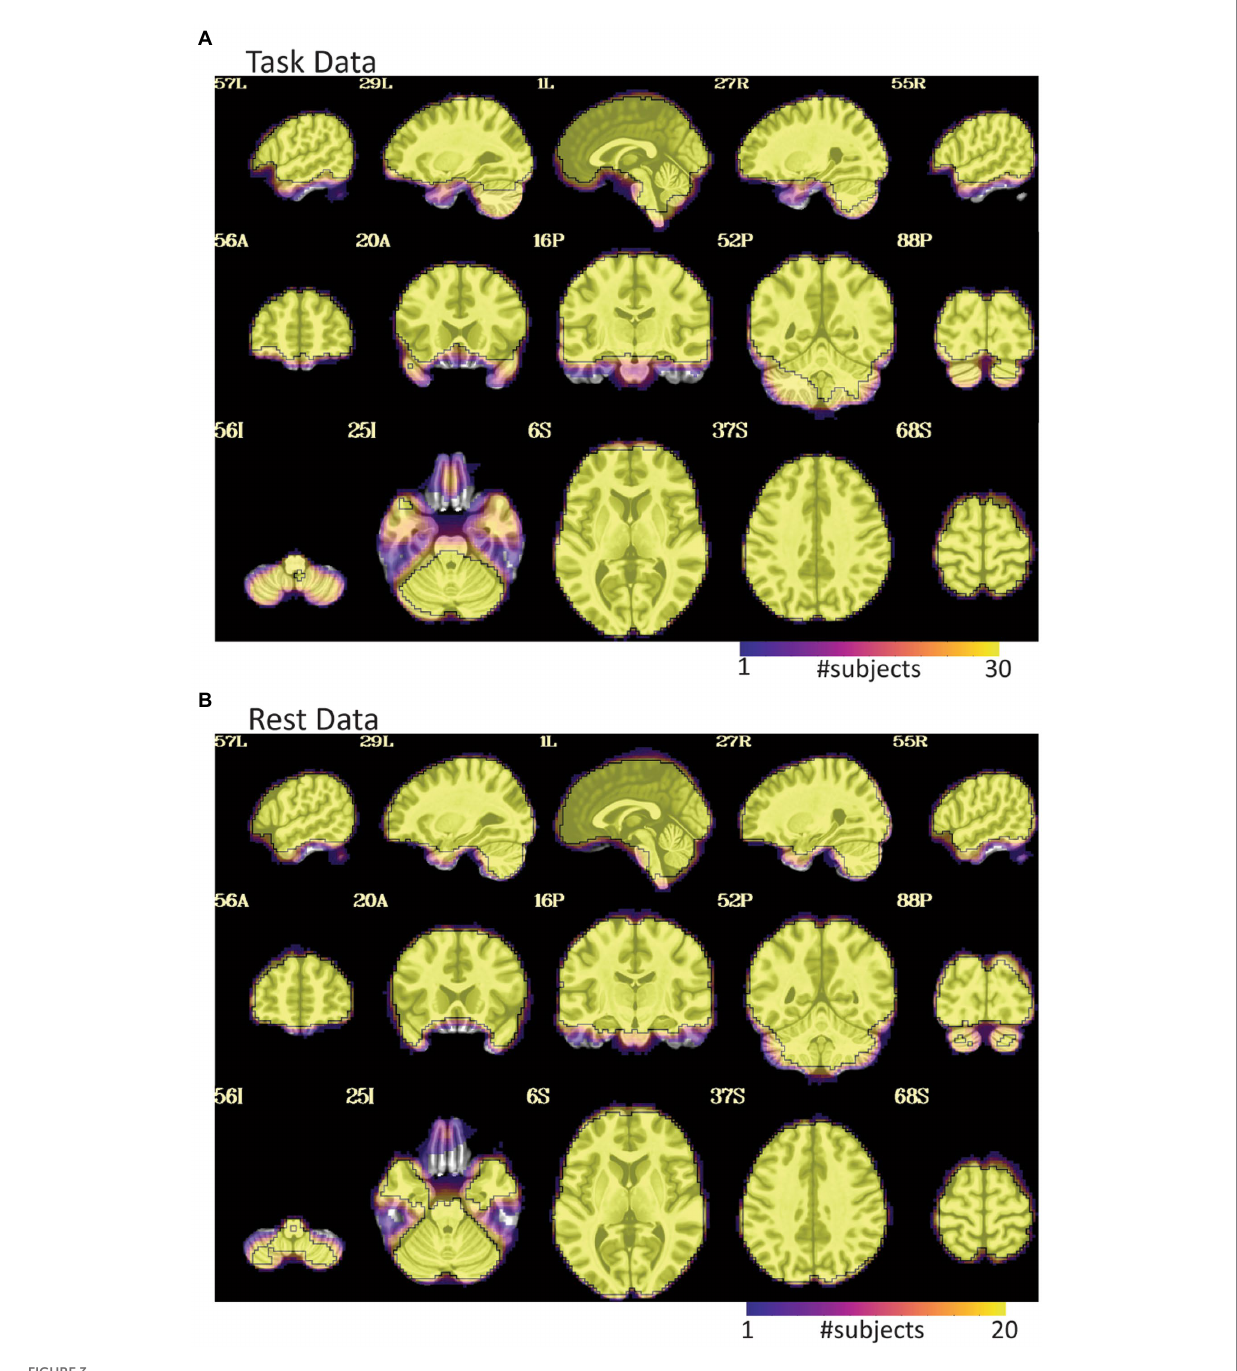
FIGURE 3 EPI coverage maps in MNI space for (A) task and (B) rest data sets. More yellow indicates that more subjects retained usable data for a given voxel. More purple indicates voxels where fewer subjects have usable data. The black outline surrounds voxels where all subjects have useable data. While both datasets show dropout in orbitofrontal and inferior temporal areas, the dropout is less consistent and more pervasive in the task data where much of the temporal lobe does not have usable data in a non-trivial fraction of subjects. The black line in (A) also highlights that not all subjects have cerebellar